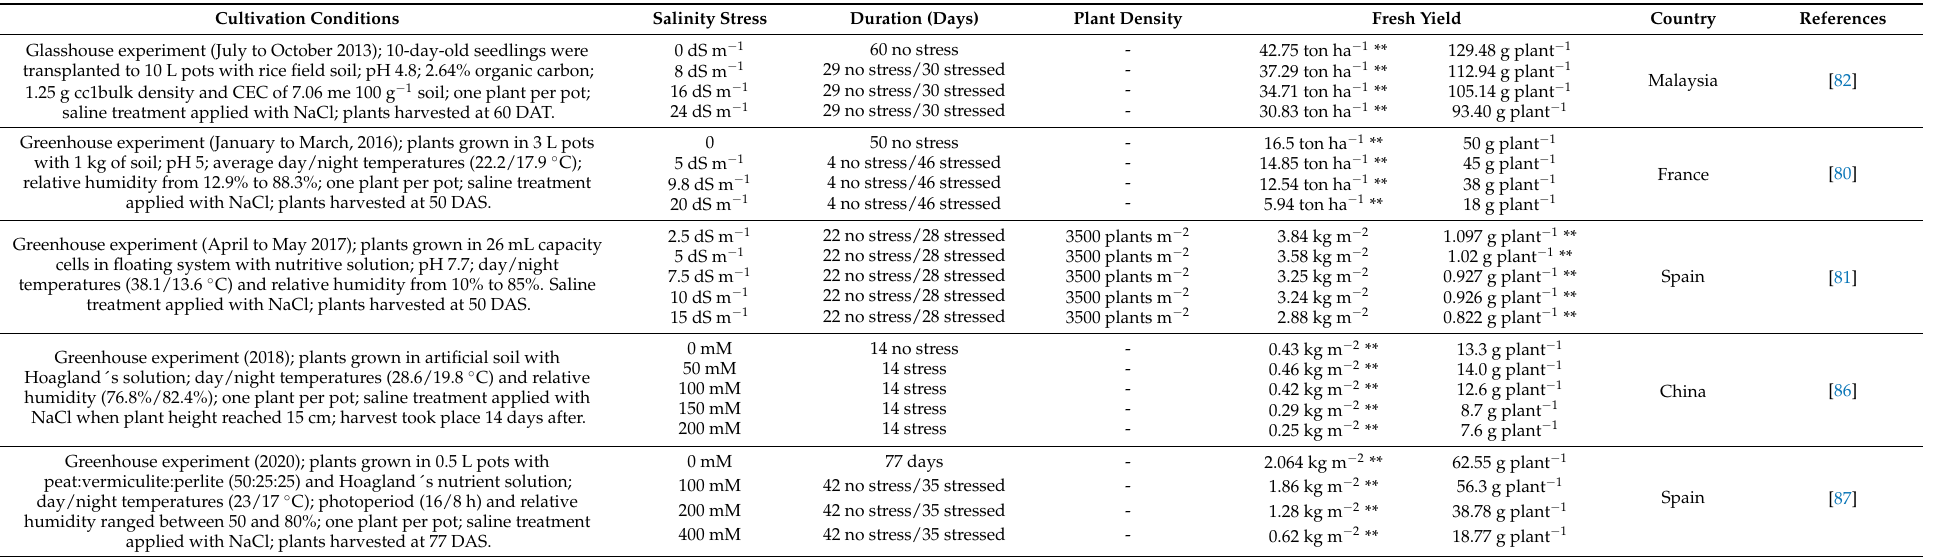
Table 2. Portulaca oleracea L. fresh yield under different salinity stress